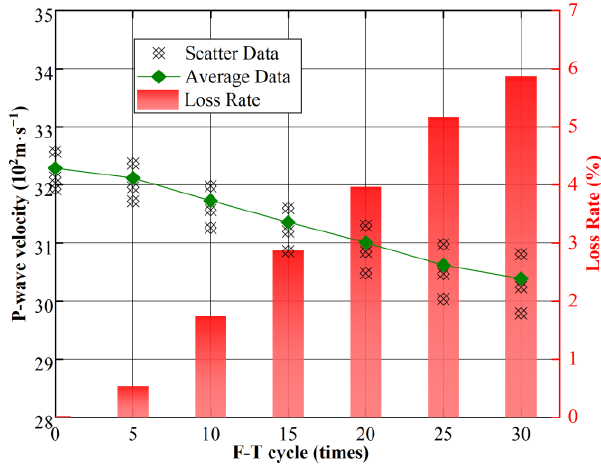
Figure 8. The average P-wave velocity and loss rate with cycles in the tested sandstone.